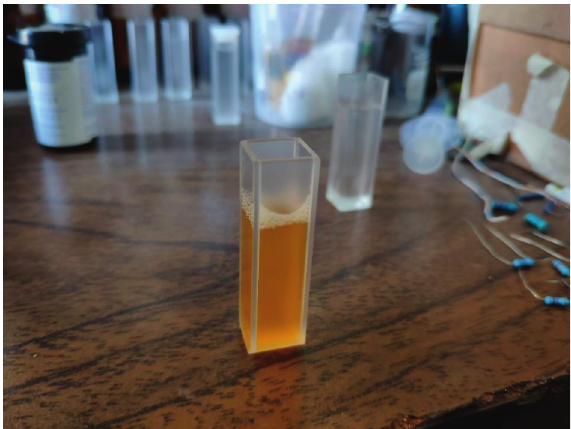
Figure 4: Blood plasma deposited in the quartz